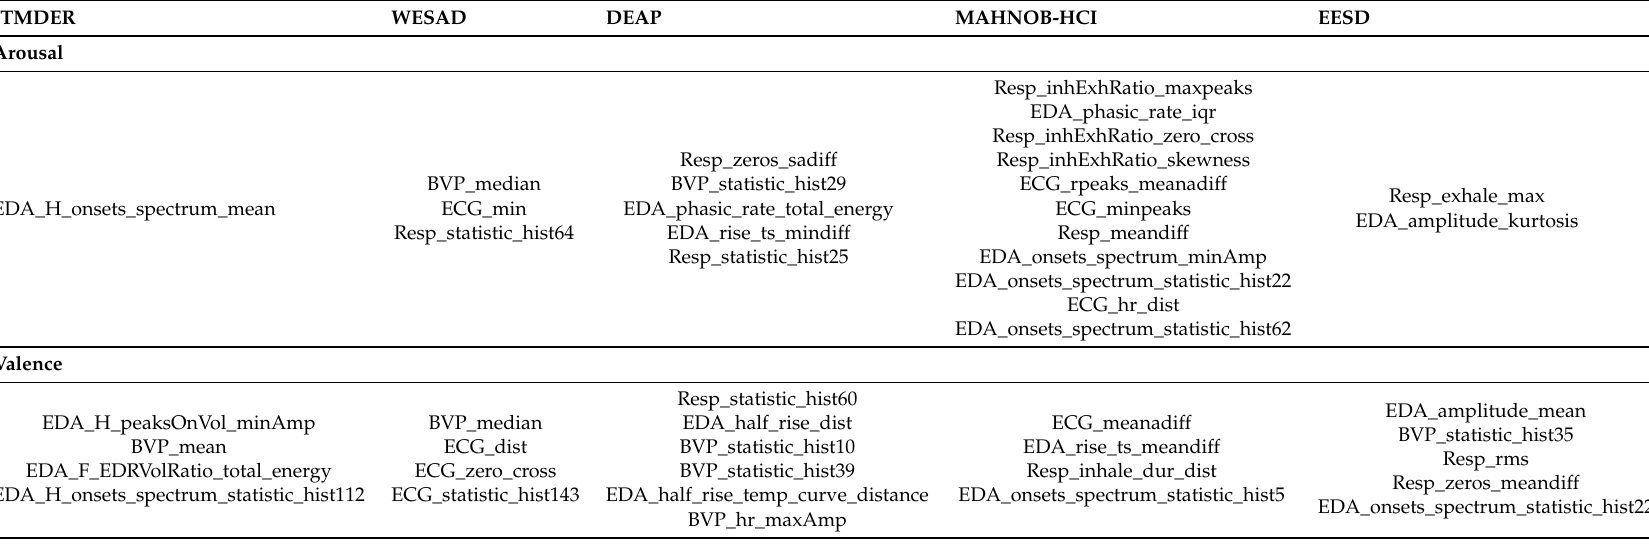
Table 8. Features used per dataset and sensor modality for the Arousal and Valence dimension in the FF methodology. Results obtained using 4-fold CV. ITMDER WESAD DEAP MAHNOB-HCI EESD